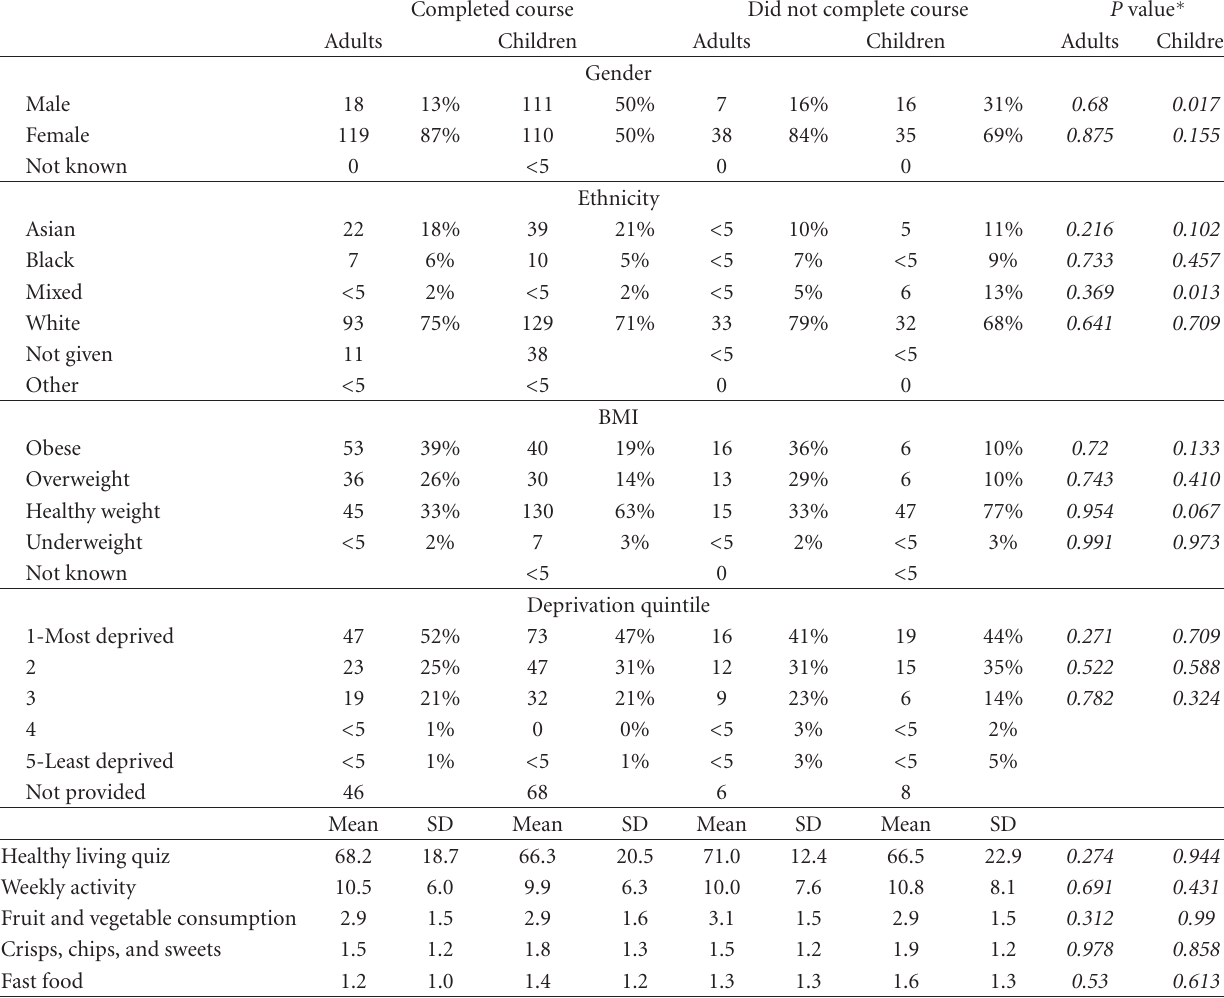
Table 2: Baseline data for OBOL participants, comparing those who completed the course with those who did not